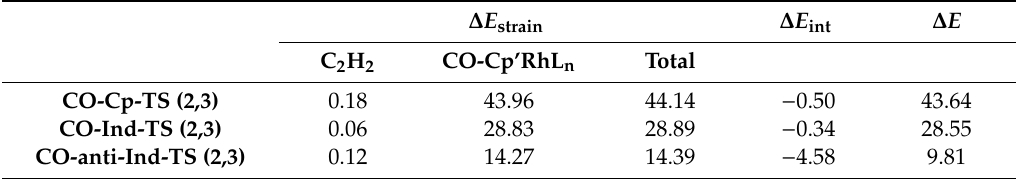
Table 6. Activation strain analysis (ASA) of the transition states CO-Cp-TS (2,3) , CO-Ind-TS (2,3) and CO-anti-Ind-TS (2,3) ; all values are in kcal mol − 1 . The fragments are CO-Cp’RhL n (Cp’ = Cp, Ind, and anti-[Cr(CO) 3 Ind]) and acetylene.